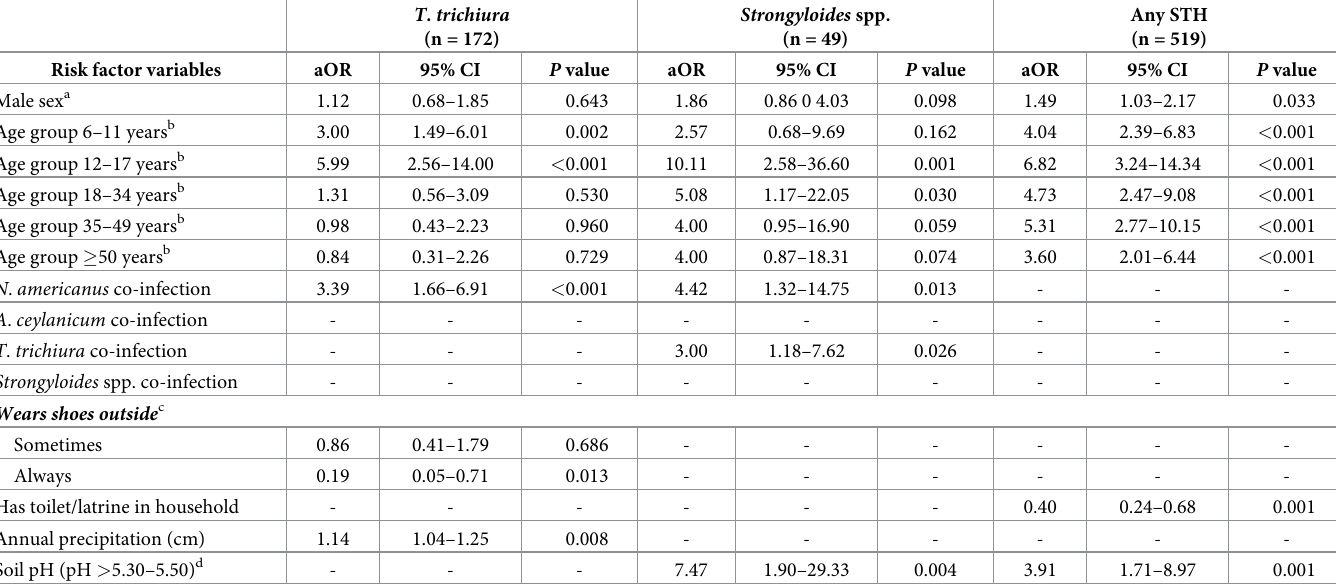
Table 5. Risk factors associated with T . trichiura , Strongyloides spp., and undifferentiated STH infection.